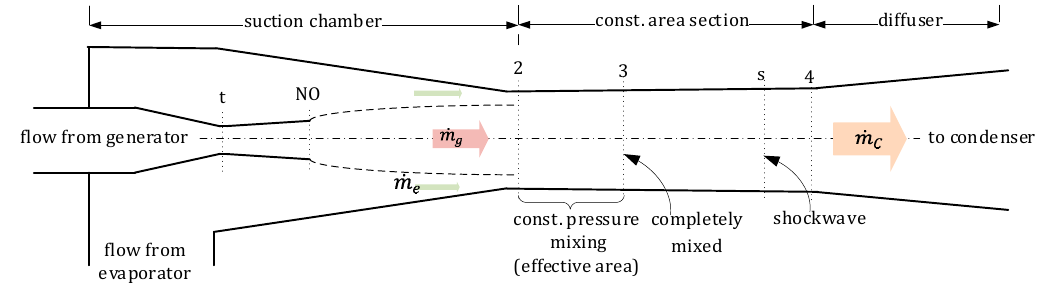
Figure 3. Schematic view of constant-pressure mixing ejector.